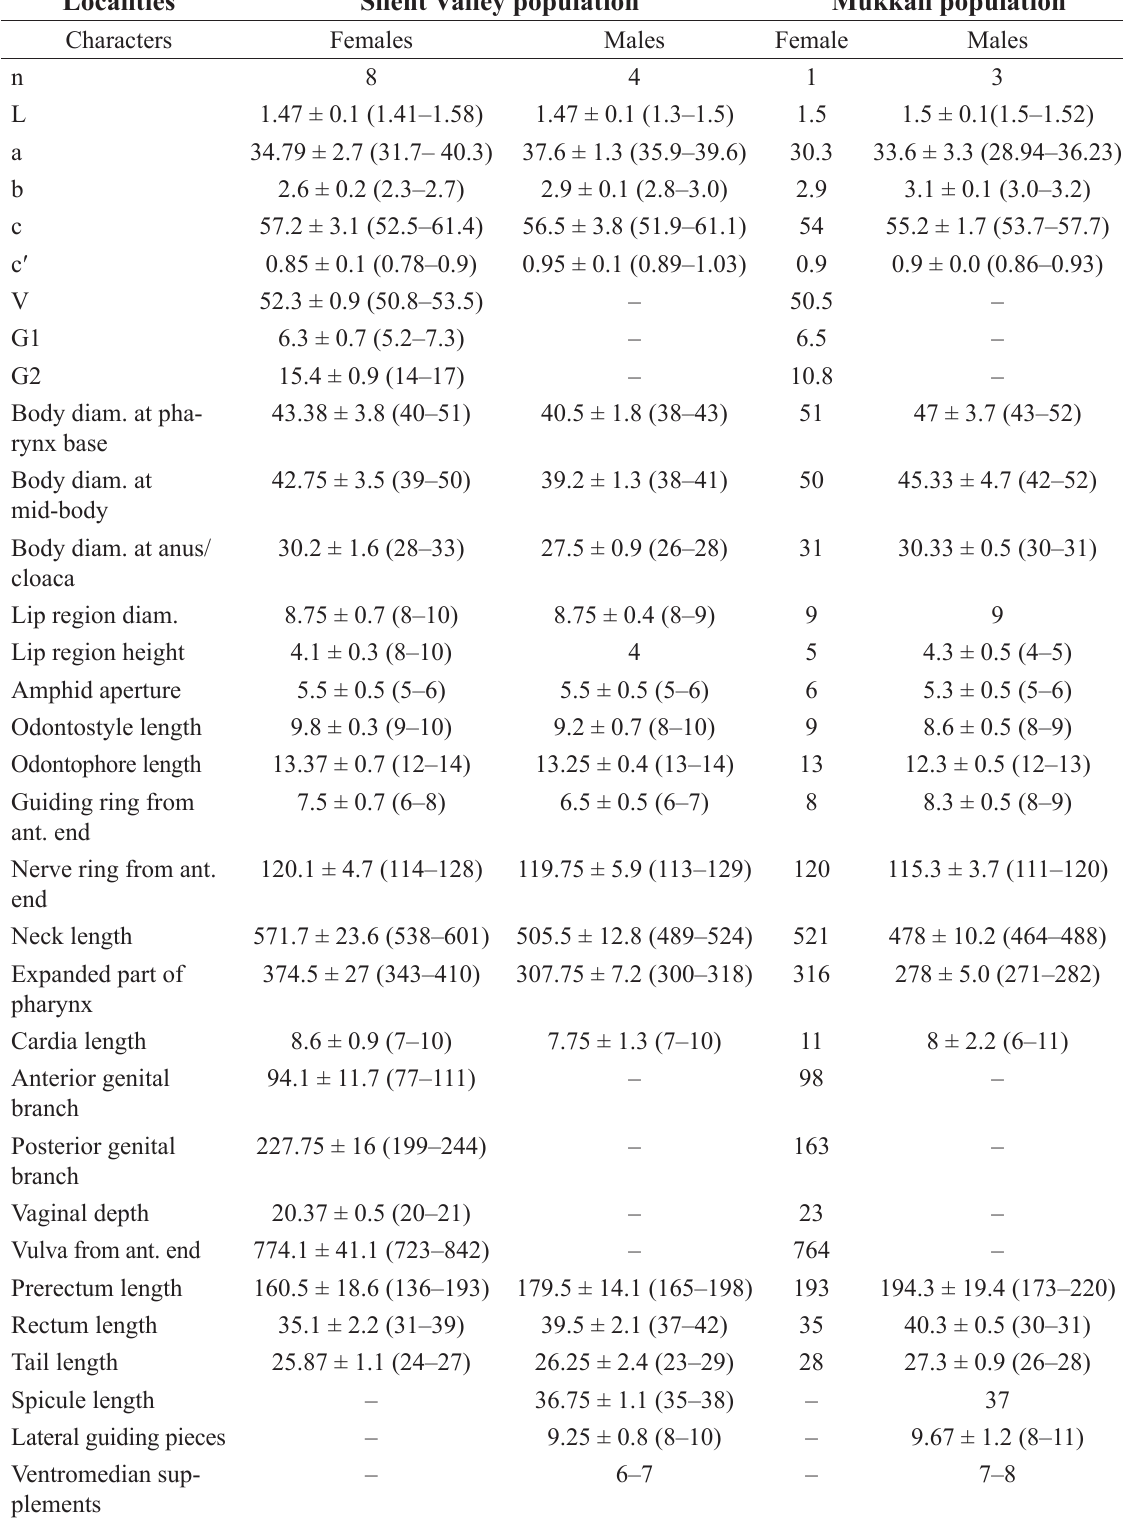
Table 3. Measurements of Axonchium transkeiense Nair, 1973. All measurements in µm except L in mm, and in the form: mean ± s.d.